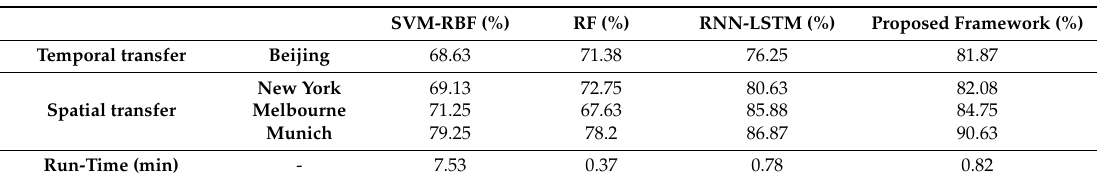
Table 3. Classification results from alternative methods with overall accuracy and run-time over temporal transfer